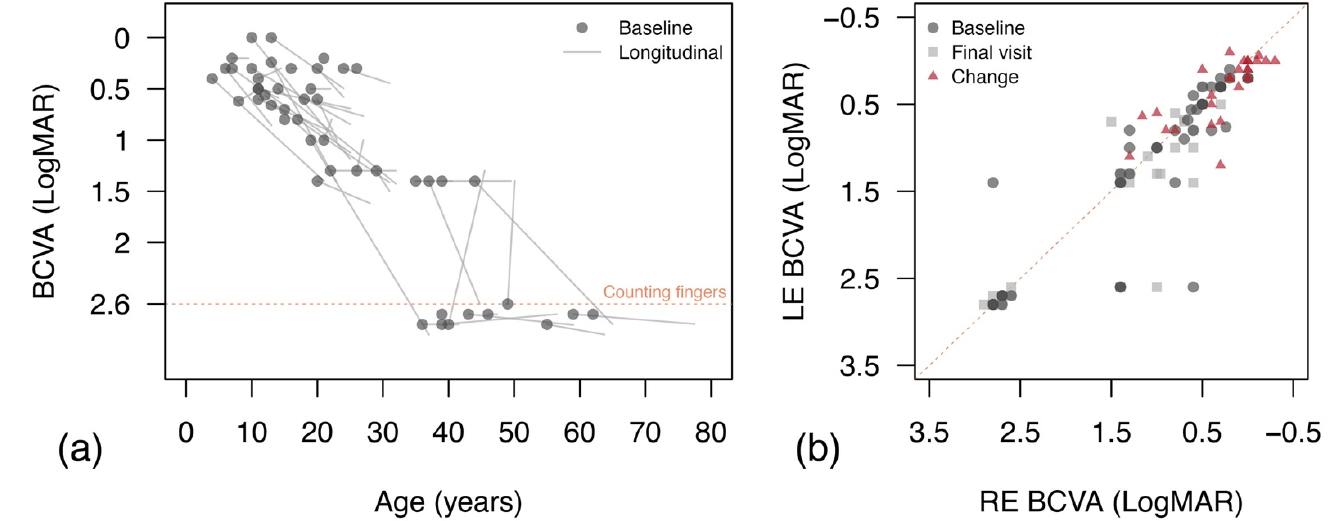
Figure 1. Changes in best corrected visual acuity (BCVA) by age and inter-ocular relationship. ( a ) BCVA measures at the first visit from all patients are reported as data points. For patients with follow-up visits, the best linear fit for all visits was reported for each patient (light grey segments). The orange line reports the BCVA level for counting fingers; ( b ) reports the inter-ocular relationship between the BCVAs of the right (RE) and left eyes (LE) at baseline, at last visit and the intervening change.